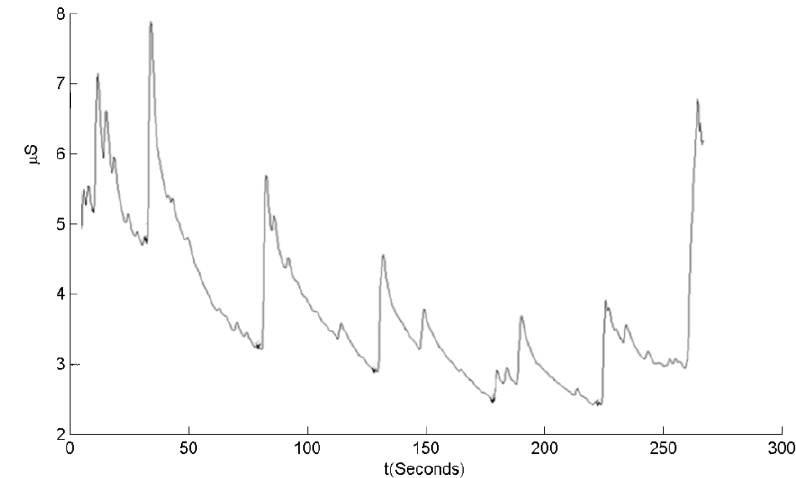
Figure 2. An example of a skin conductance